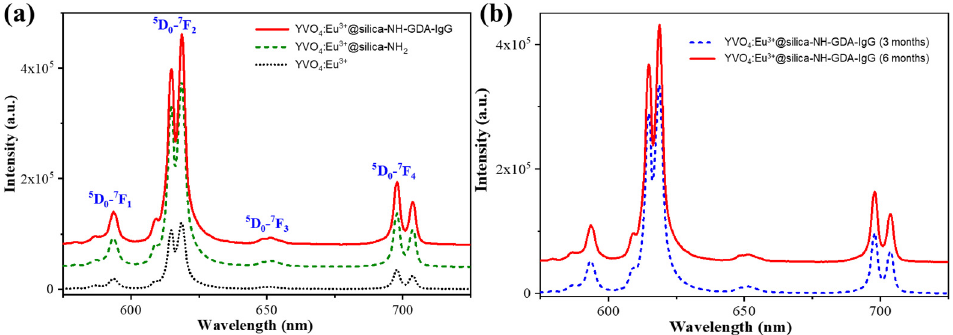
Figure 3. ( a ) PL spectra of the YVO 4 :Eu 3+ , YVO 4 :Eu 3+ @silica-NH 2 , and YVO 4 :Eu 3+ @silica-NH-GDA-IgG nanoparticles under a 355 nm excitation. ( b ) PL spectra of the YVO 4 :Eu 3+ @silica-NH-GDA-IgG nanoparticles measured after three and six months of the synthesis.